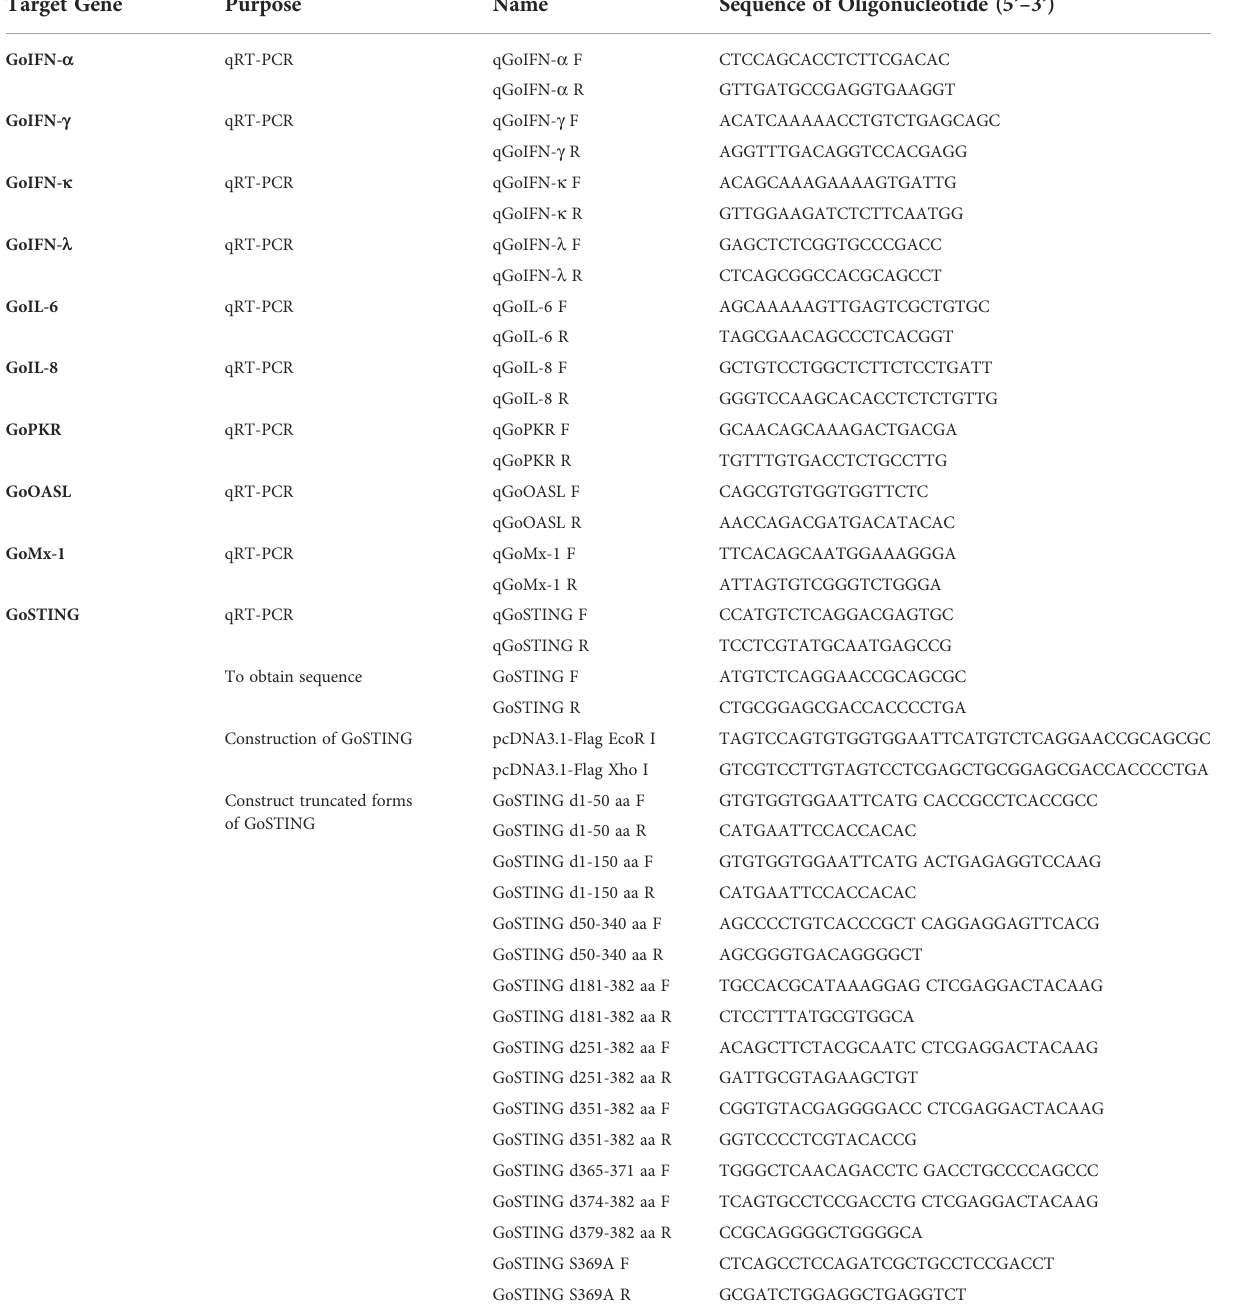
TABLE 1 PCR primers used in this